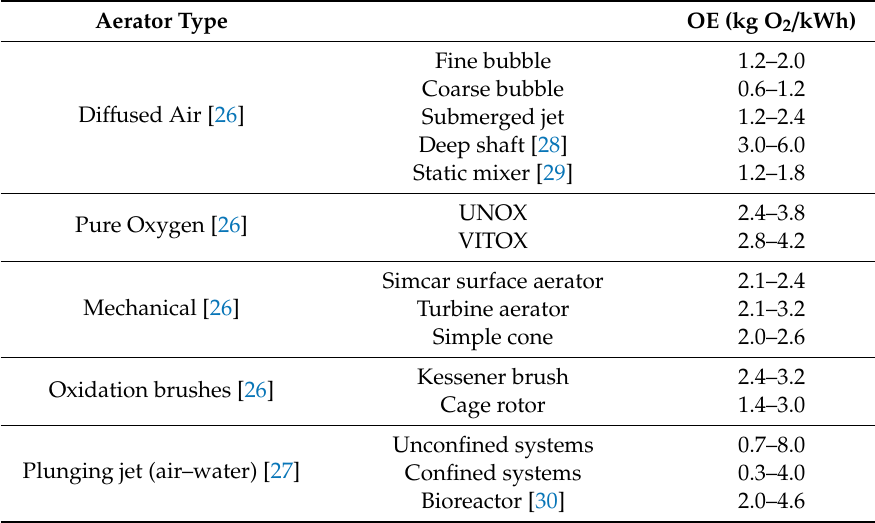
Table 1. Oxygenation e ffi ciency values of various